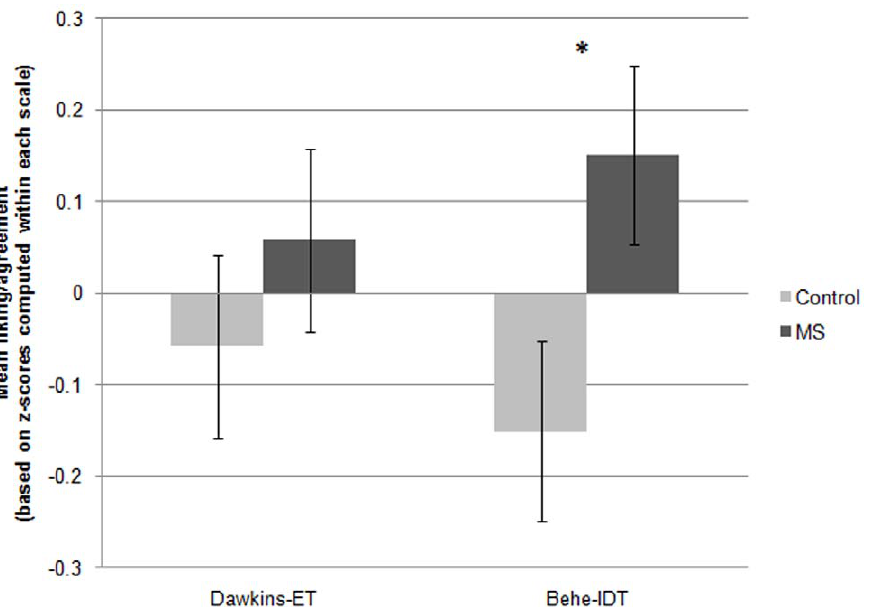
Figure 1. Effects of mortality salience (MS) on liking of Behe and belief in intelligent design theory (IDT), and liking of Dawkins and belief in evolutionary theory (ET), Study 1. Note. Values are based on standard scores; means for each scale were computed by standardizing each of the six author-theory items that the scale comprised, around their common mean, and taking the mean of the resulting z-scores. Because the two scales were centered around different means, values on the two scales (Dawkins-ET and Behe-IDT) cannot be directly compared to each other. Based on a t -test, the difference between the control and MS conditions on Behe-IDT was significant, p , .05. Error bars represent the standard error of the mean. * p , .05.